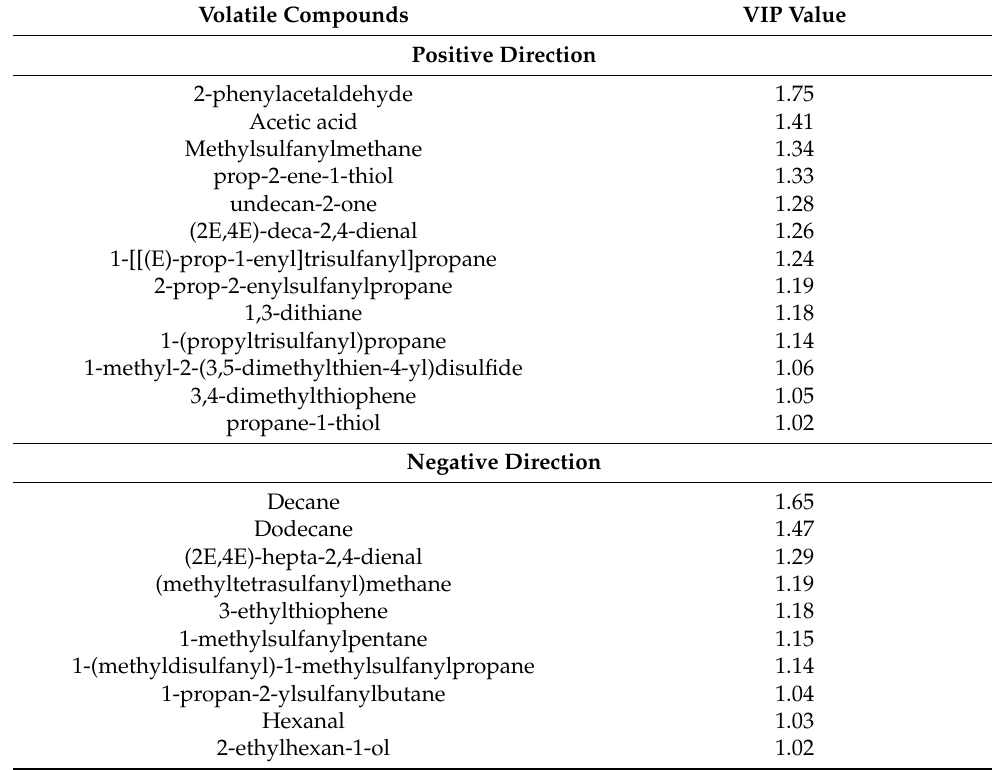
Table 4. The major volatile compounds identified in the heated Welsh onion samples added with different antioxidants, based on the variable importance plot (VIP > 1.0) list for PLS component 2 of